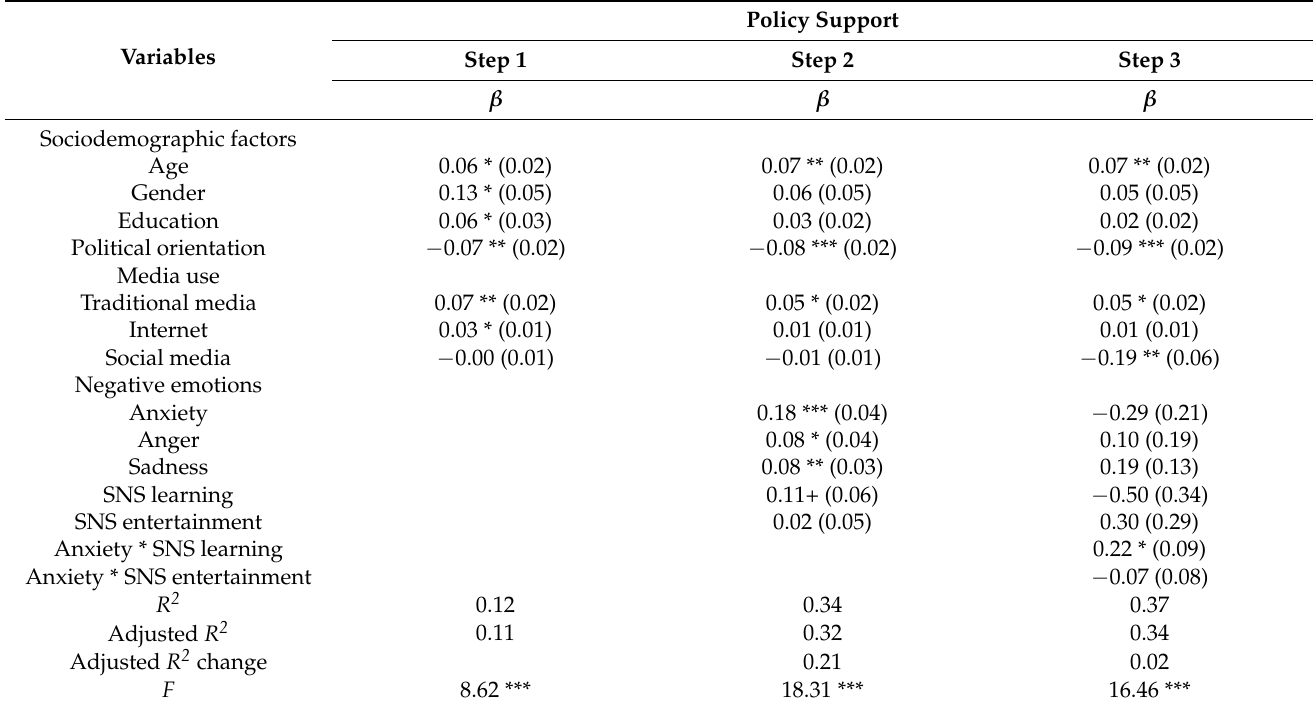
Table 4. Hierarchical regression analyses predicting policy